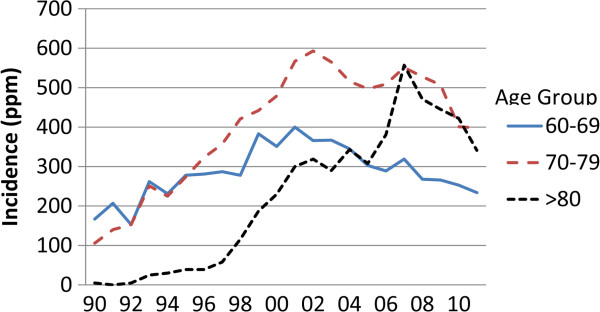
Incidence of ESRD in patients>60 years 1990–2011.